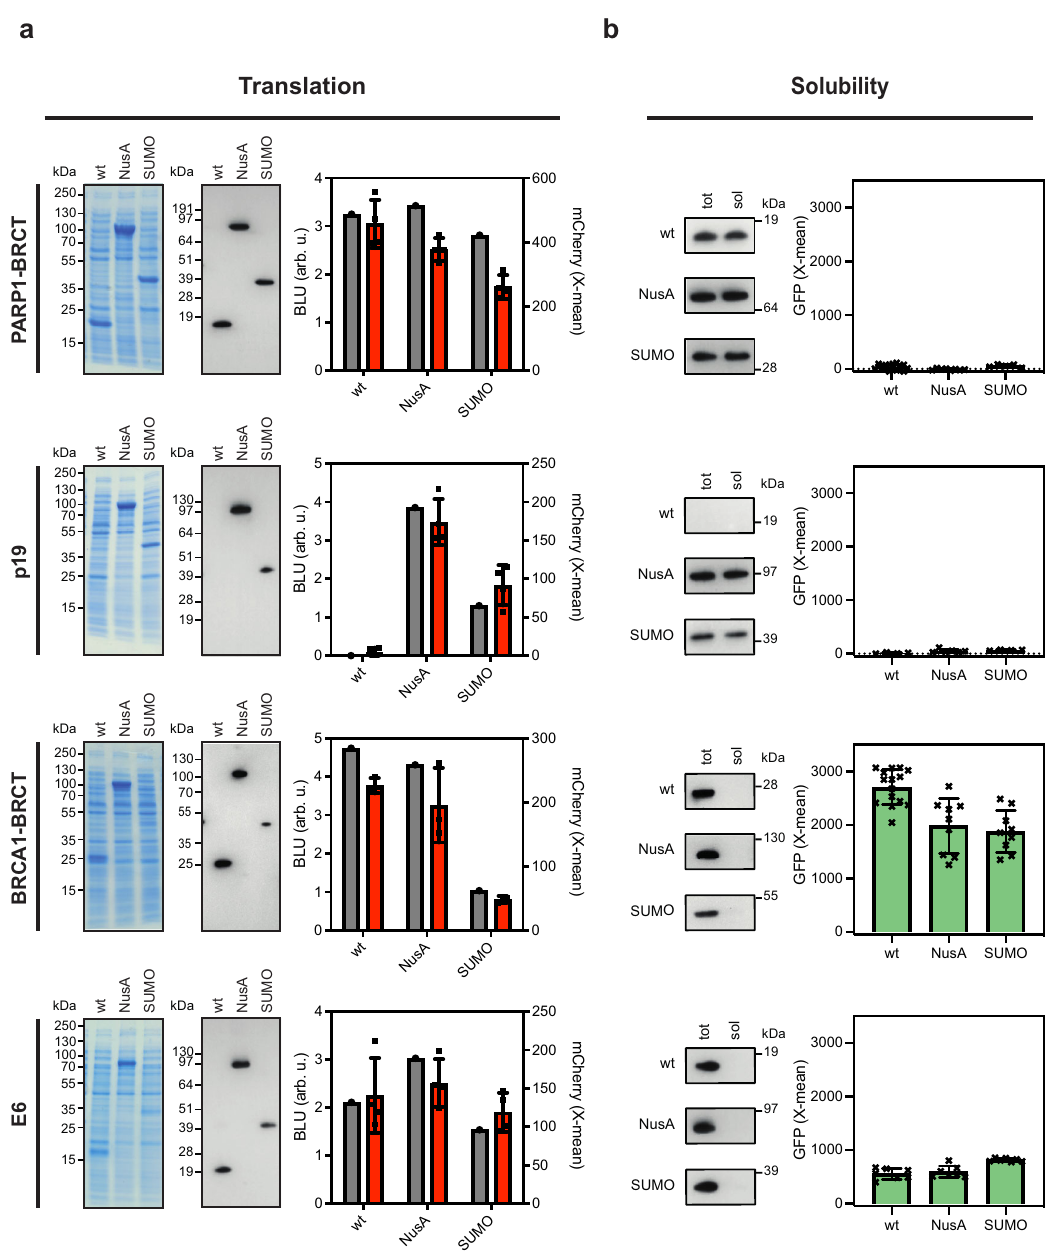
Fig. 3 Validation of the dual protein translation and misfolding biosensor. The solubility tags NusA and SUMO were fused to four proteins; PARP1-BRCT, p19, a truncated BRCA1-BRCT, and E6, with known propensities for misfolding. a The proteins were translationally coupled to the fl uorescent protein mCherry to monitor the translation using FACS. Data are presented as mean values ± standard deviation for biologically independent samples analyzed for each plasmid combination ( n = 4 for PARP1-BRCT, p19 and E6, and n = 3 for BRCA1-BRCT). Protein expression was analyzed by SDS-PAGE analysis and quanti fi ed from a single Western blot for each cell line (gray) (BLU = biochemical luminescence unit) and correlated to the mean mCherry fl uorescence signal from the analysis of 10,000 cells (red). b Western blot analysis of total protein yield (tot) and soluble protein (sol) after fractionated cell disruption shown together with the quanti fi ed GFP response signal for insoluble protein. Data are presented as mean values ± standard deviation based on 4 biologically independent samples. Source data are provided as a Source Data fi le.